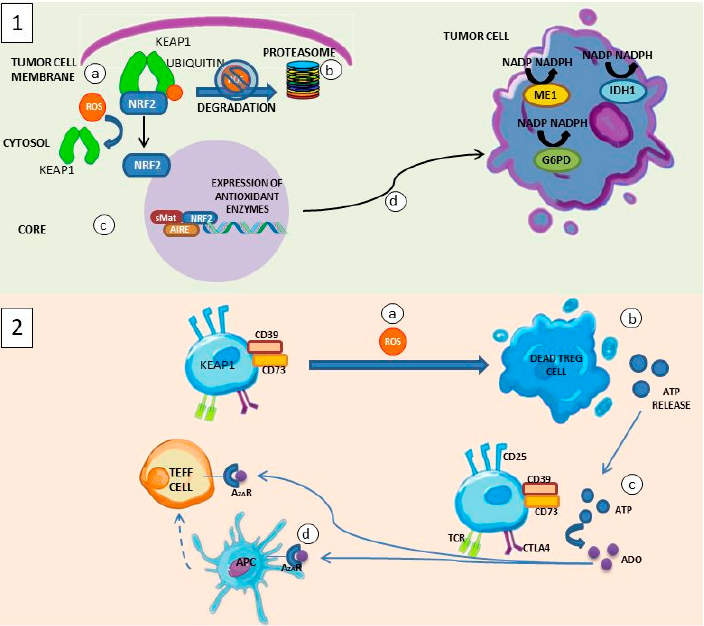
Figure 5. ROS and the tumor microenvironment. ( 1 ) Within the tumor microenvironment, tumor cells are able to survive by presenting oncogenic mutations such as that generated by Nrf2. (a) In the tumor cell cytosol, increased ROS levels prevent Nrf2 degradation mediated by Kelch-like ECH-associated protein 1 (KEAP1). (b) In the absence of ROS, Nrf2 will be degraded via the ubiquitin proteasome pathway. (c) When separated from KEAP1, Nrf2 translocates to the nucleus of the tumor cell where, together with Maf proteins, it binds to the antioxidant response element (ARE) and allows the expression of genes that code for the generation of antioxidant enzymes. (d) The tumor cell expresses NADPH-generating enzymes such as ME1, IDH1, and G6PD. ( 2 ) (a) Treg cells are susceptible to ROS-induced death. (b) A dead Treg cell will give way to the release of ATP. (c) ATP will be metabolized to adenosine (ADO) by CD39 AND CD73 of another Treg cell. (d) The generation of ADO is one of the suppression mechanisms of the antitumor immune response promoted by Treg cells because of the binding to the A2AR of effector T lymphocytes (Teff) and APCs as it generates immunosuppressive signals.